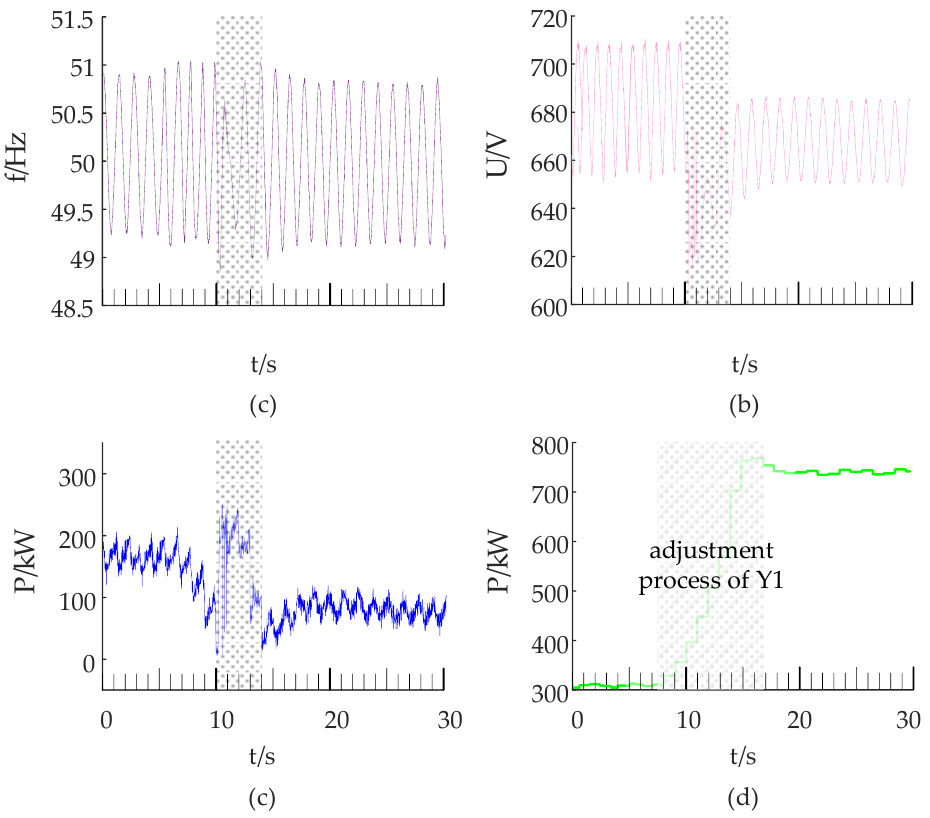
Figure 12. ( a ) system frequency, ( b ) system voltage, ( c ) active of Gd, ( d ) active power of Y1.